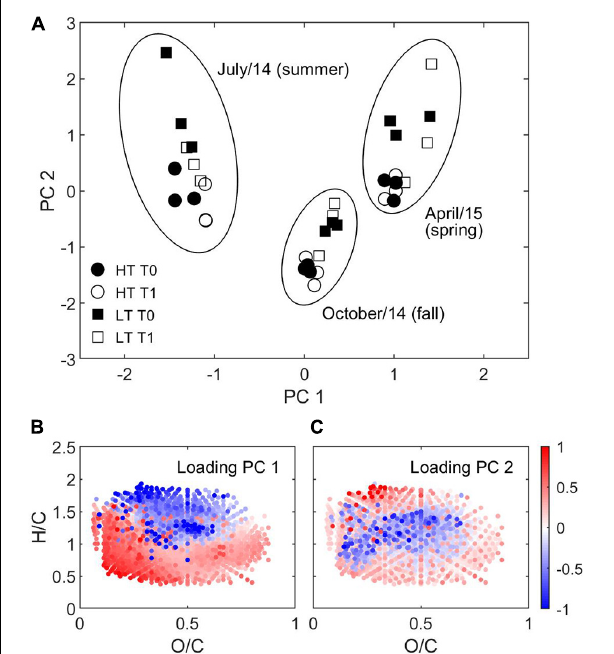
FIGURE 3 | Principal component analysis of DOM composition. (A) Scores of the principal components from the same month are circled and labeled. Solid and open symbols represent T0 and T1, respectively. Circle and square symbols represent high tide and low tide, respectively. Van Krevelen diagrams color coded with loadings of (B) PC 1 and (C) PC 2 are also shown. The first and second principal components explained 28% and 10% of the